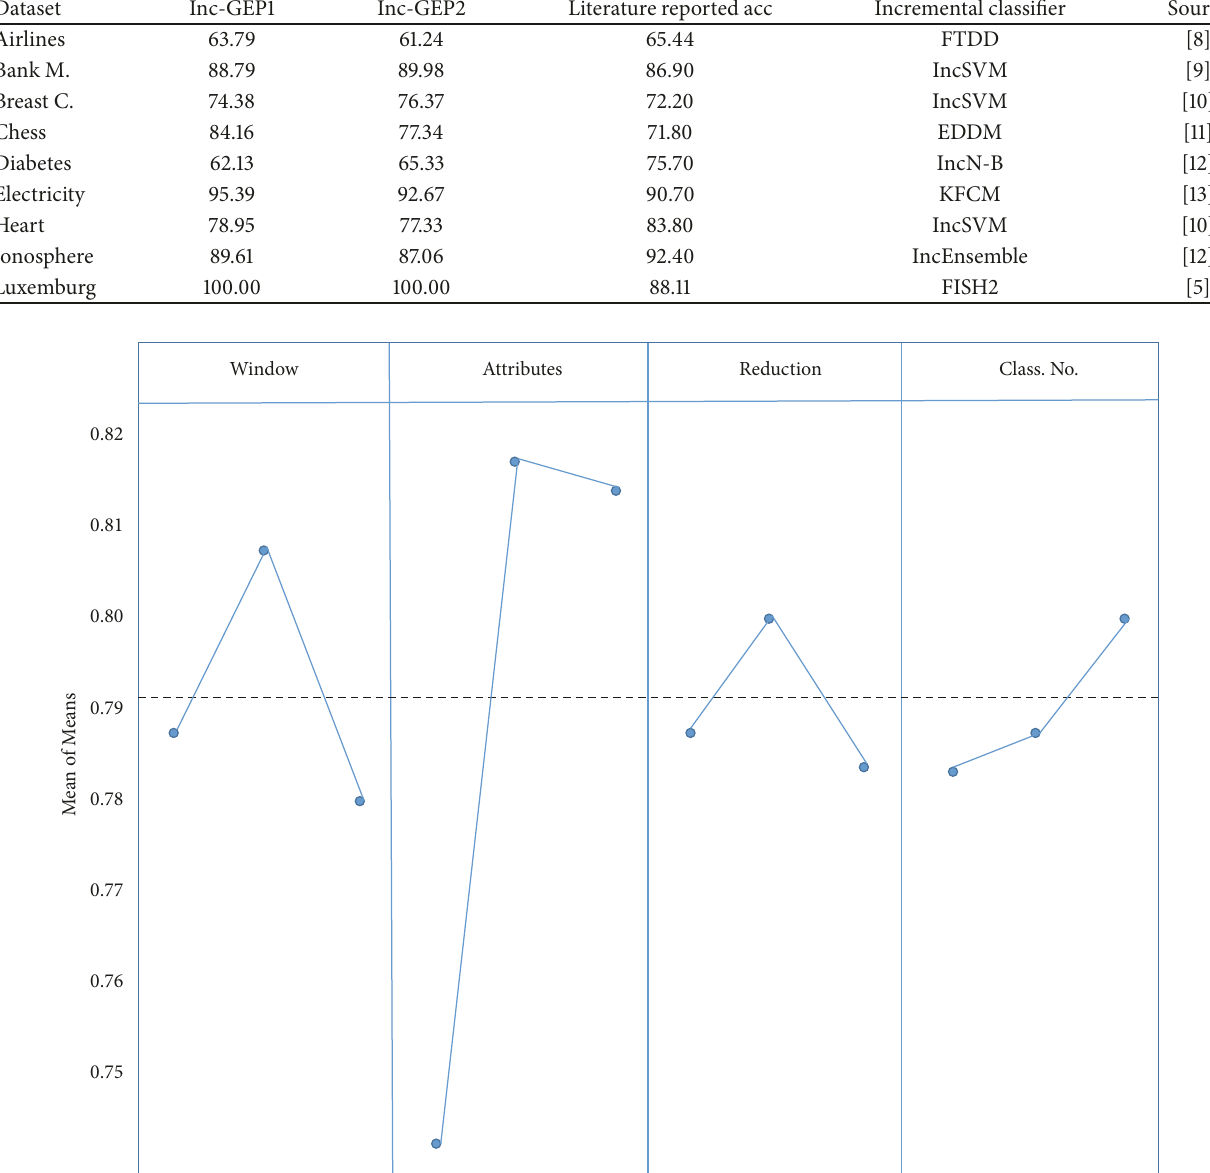
Table 9: Comparison of the proposed GEP-based incremental classifiers with some literature reporting incremental classifiers in terms of the mean classification accuracy.